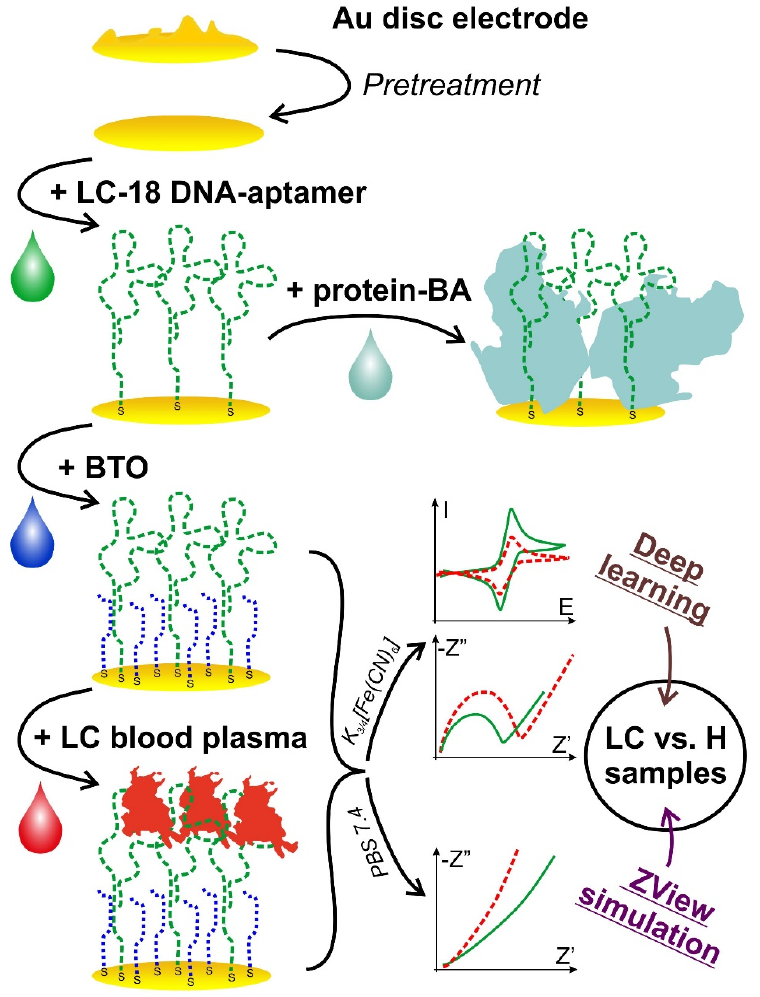
Figure 1. A schematic representation of the aptasensor preparation and study process. Top-down: electrode pretreatment stage; aptamer immobilization; protein BA (to the right) or BTO that is an oligo-BA (downward) immobilization; incubation with the blood plasma; electrochemical measurements in two solutions and data processing (to the right).